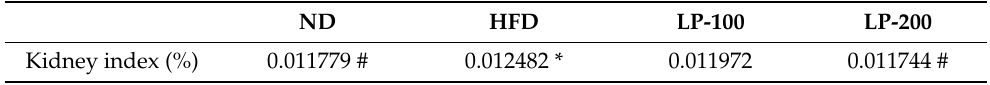
Table 2. Effect of LPs on kidney index of